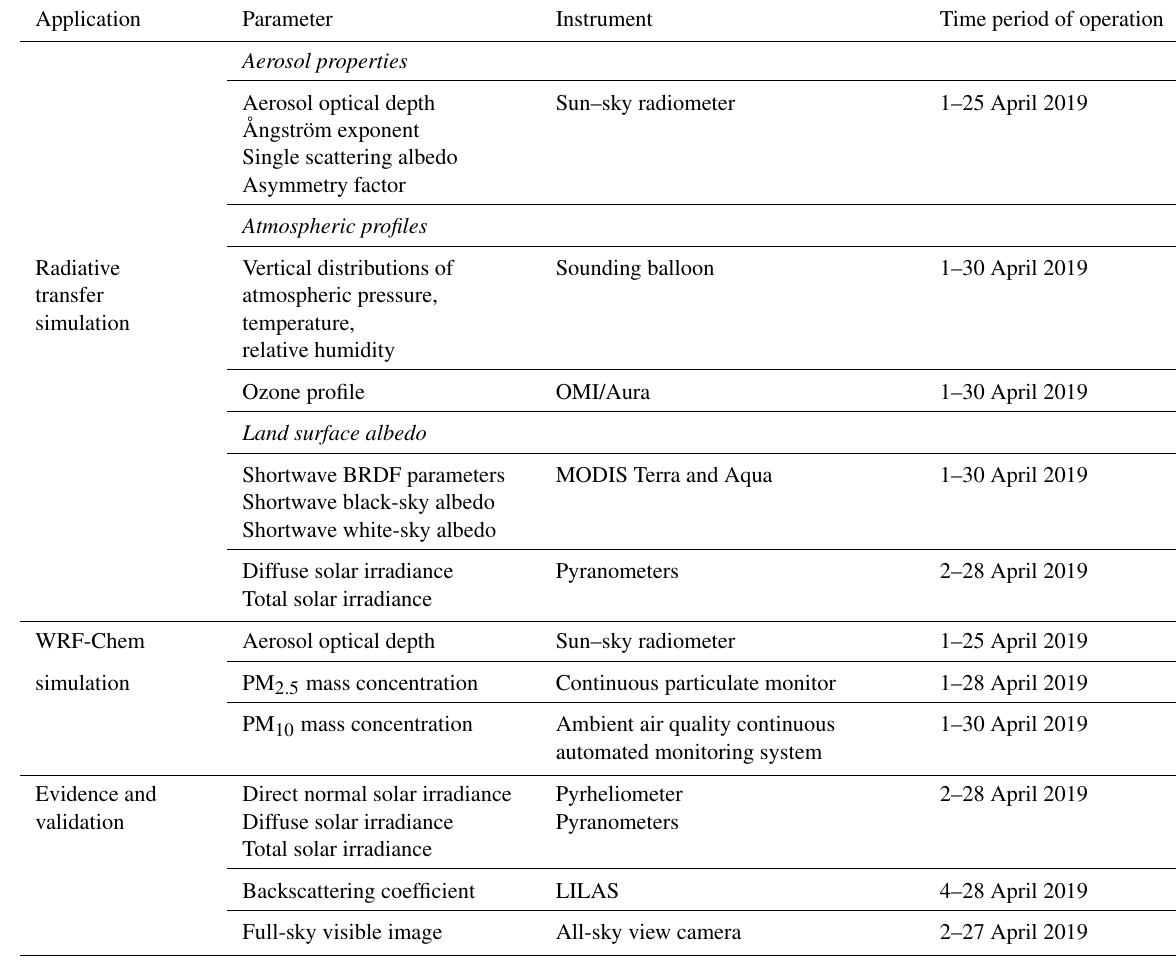
Table 1. Overview of the parameters and instruments employed in the radiative transfer and WRF-Chem model simulations and